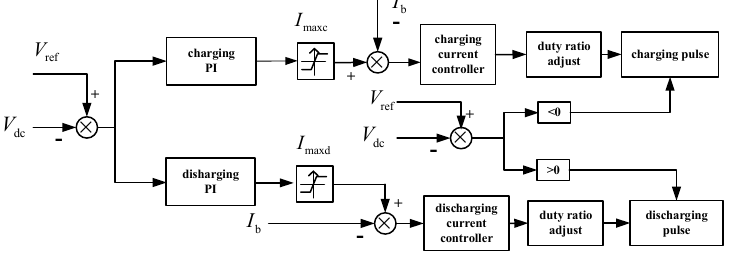
Figure 2. The control block diagram of the bidirectional DC-DC power converters (BDC).